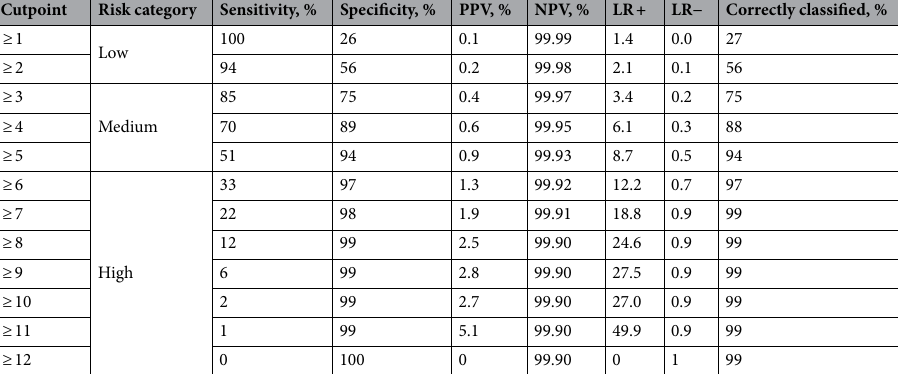
Table 3. Test characteristics of the emergency department in-hospital cardiac arrest score (EDICAS). PPV positive predictive value, NPV negative predictive value, LR + positive likelihood ratio, LR− negative likelihood